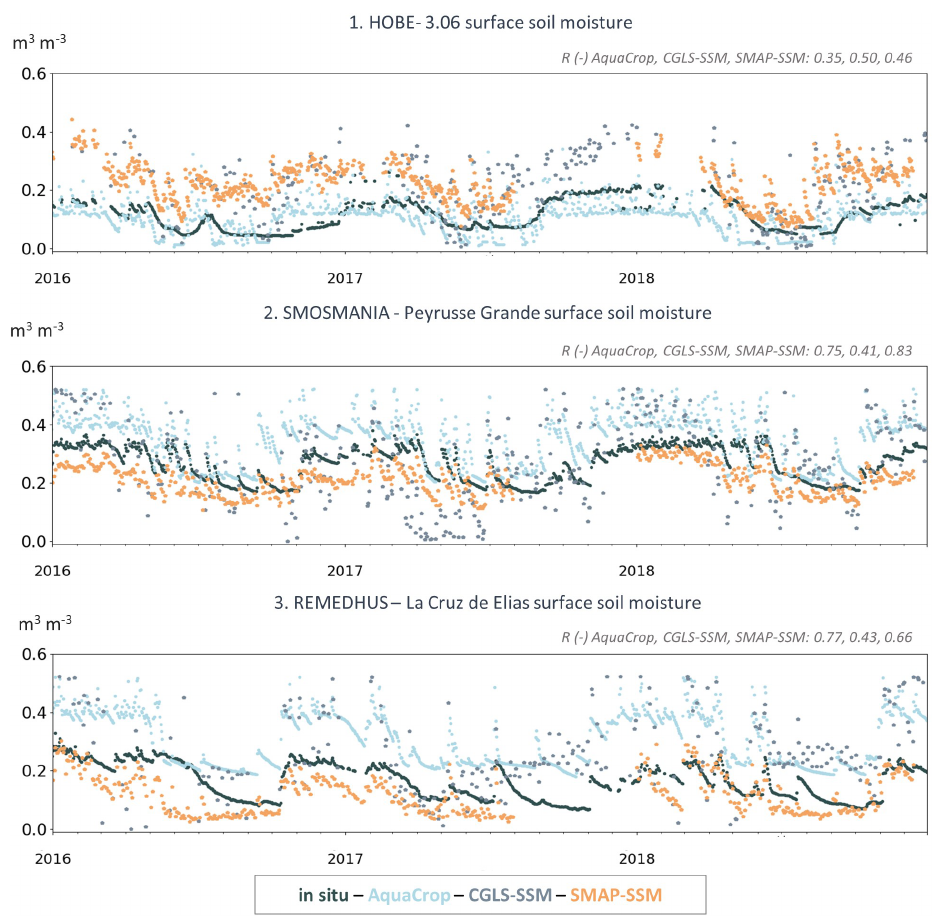
Figure 9. Time series of daily surface soil moisture at three locations marked in Fig. 6a: 1 ( ∼ 55 ◦ 54 (cid:48) N, 8 ◦ 52 (cid:48) E), 2 ( ∼ 43 ◦ 39 (cid:48) N, 0 ◦ 13 (cid:48) E), and 3 ( ∼ 41 ◦ 17 (cid:48) N, 5 ◦ 18 (cid:48) W). AquaCrop (light blue) in situ measurements (dark grey), CGLS-SSM (light grey), and SMAP-SSM (orange). Pearson correlations R of in situ data with the different products are given for each